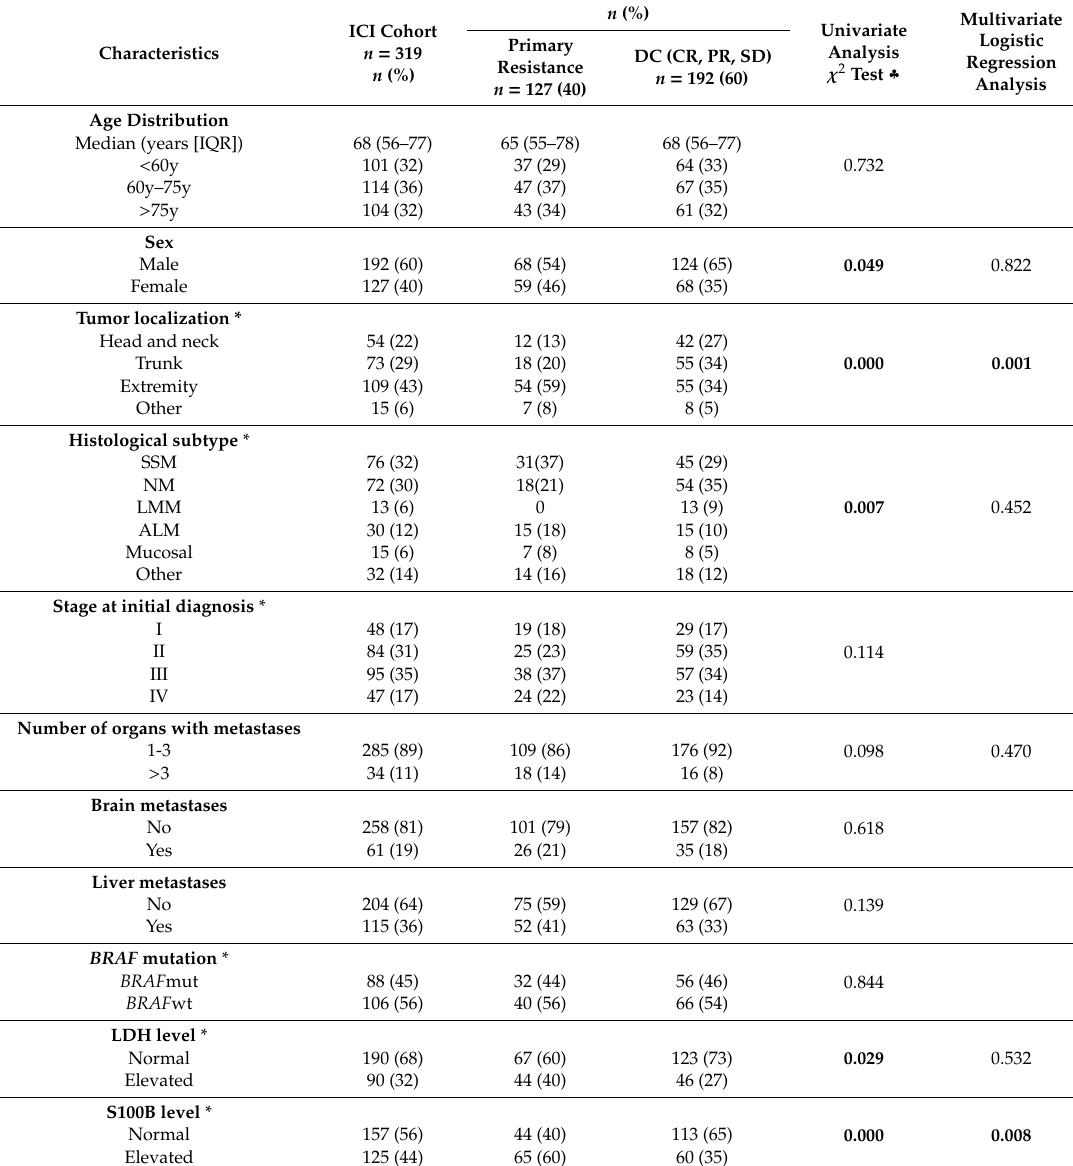
Table 1. Patients characteristics, univariate and multivariate analysis for the whole cohort, according to best overall response to first-line PD-1-based immunotherapy.